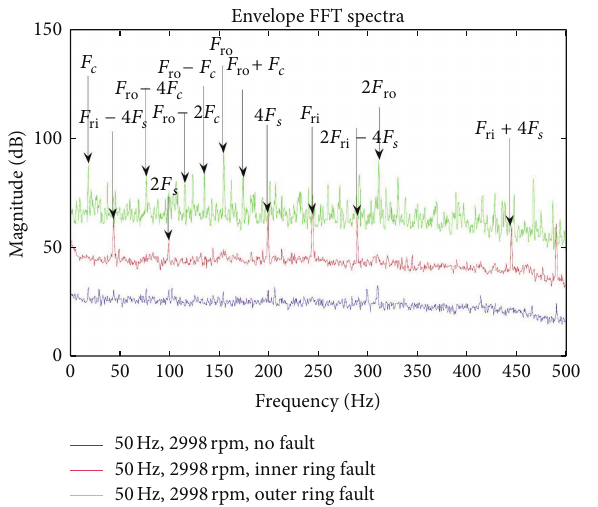
Figure 5: Nominal, inner defect, and outer defect spectra of 50 Hz motor input, free load condition, and radial vibration measure- ments.